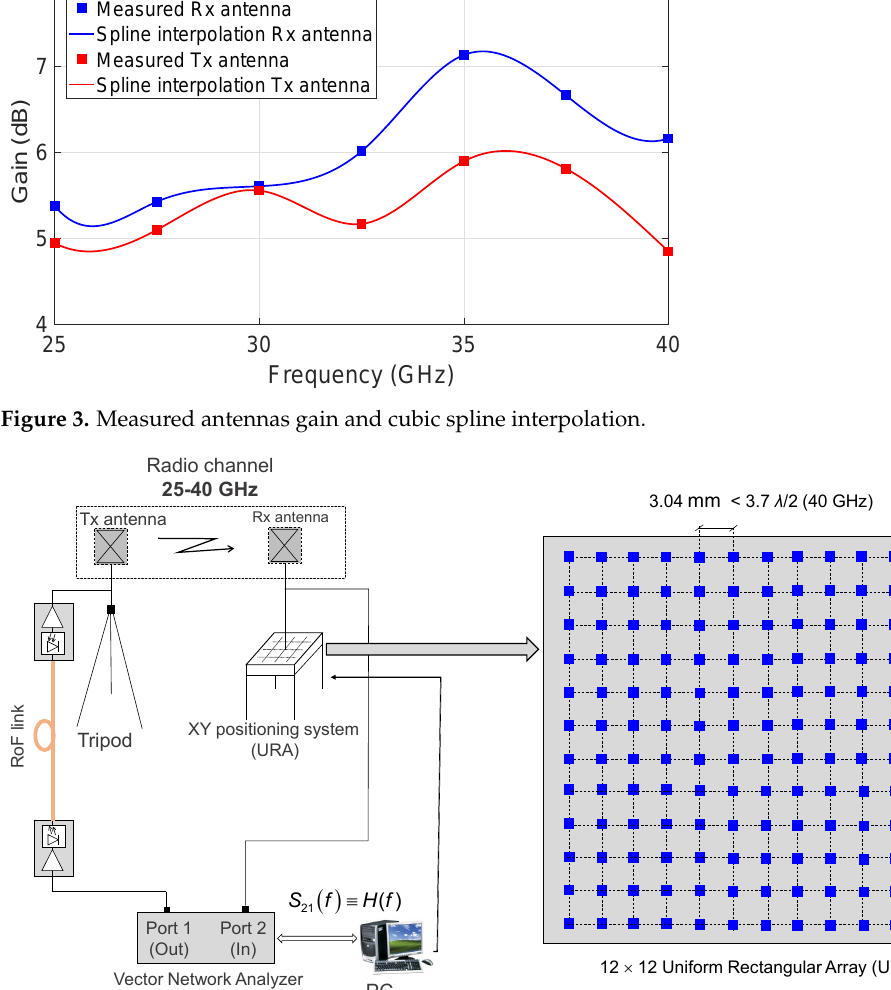
Figure 4. Schematic of the channel sounder used in the propagation channel measurements. The RoF link is placed in the Tx side (Port 1 of the VNA) and the horizontal positioning system in the Rx side (Port 2 of the